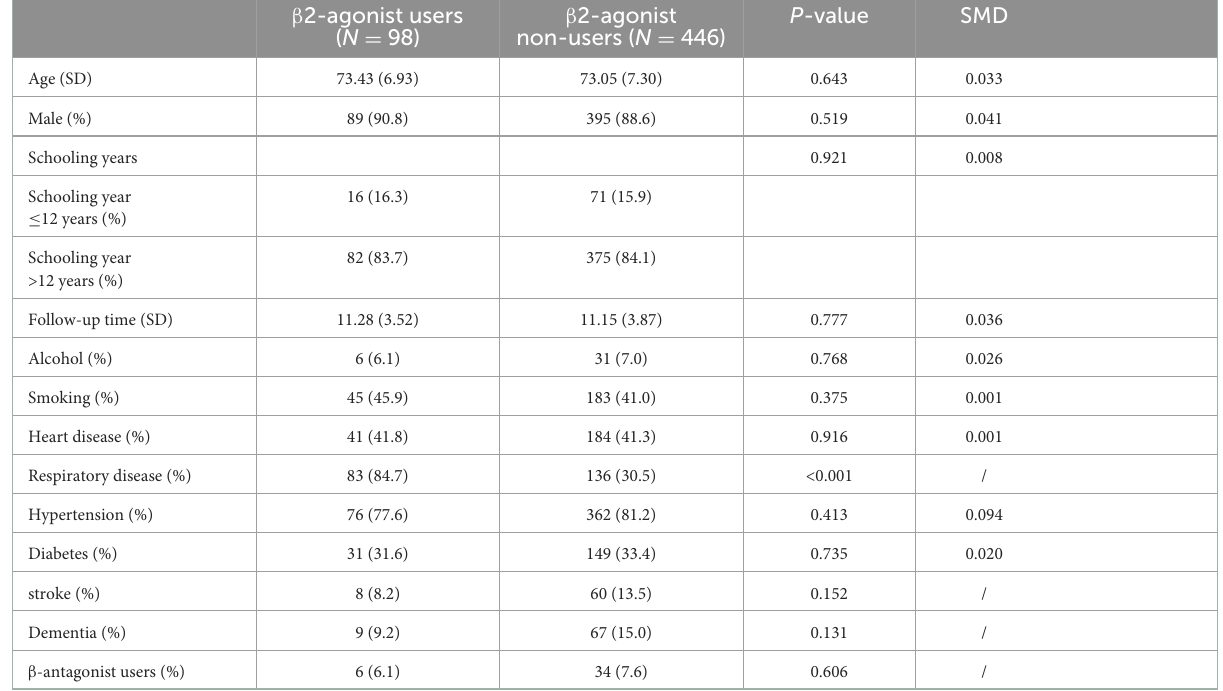
TABLE 1 Characteristics of β 2-agonist users and their matched controls.